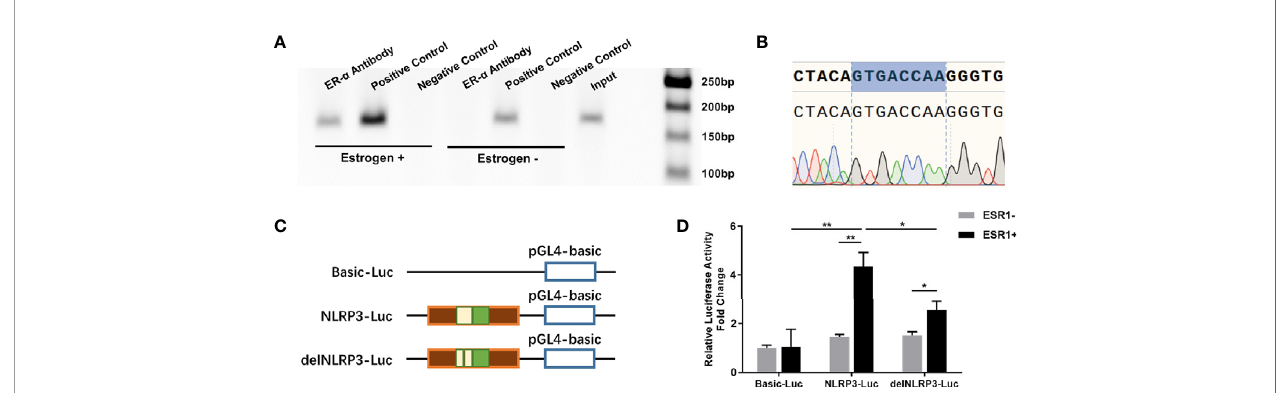
FIGURE 2 | ERE sites in the NLRP3 promoter mediated estrogen-induced NLRP3 transcription. (A) ChIP analysis was performed using anti-ER- a or anti-Histone H3 antibody to ascertain the existence of the ERE in the promoter of the NLRP3 gene. The PCR results showed that a 159-bp fragment containing the presumed ERE could be precipitated after P815 cells were treated with b -estradiol for 24 h. (B) The pulled-down band was excised from the gel and sequenced. (C) Schematic diagram of luciferase reporter constructs. Basic-Luc: pGL4-basic plasmid; NLRP3-Luc: pGL4-basic plasmid with the NLRP3 promoter fragment including presumed ERE-like sequence; delNLRP3-Luc: pGL4-basic plasmid with the mutant NLRP3 promoter fragment, with the presumed ERE-like sequence deleted. (D) Luciferase activities of three report systems with or without ESR1 plasmid co-transfection in 293T cells were compared with each other. Renilla luciferase plasmid was used to normalize transfection ef fi ciencies. The experiments were repeated three times and data are presented as means ± SEM. Statistics: Unpaired Student ’ s t-test. * P < 0.05, ** P <